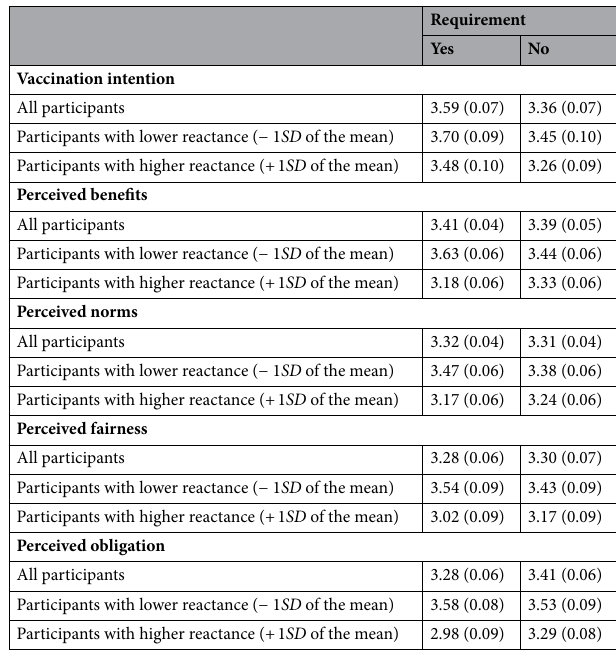
Table 5. Effects of requiring vaccination and psychological reactance on intentions, perceived benefits, norms, fairness, and obligation: Study 4. Table entries are means and standard errors (parenthetically) obtained from analyses of covariance. Intentions were measured on a 1–5 scale, where 1 = extremely unlikely, 2 = somewhat unlikely, 3 = neither likely nor unlikely, 4 = somewhat likely, and 5 = extremely